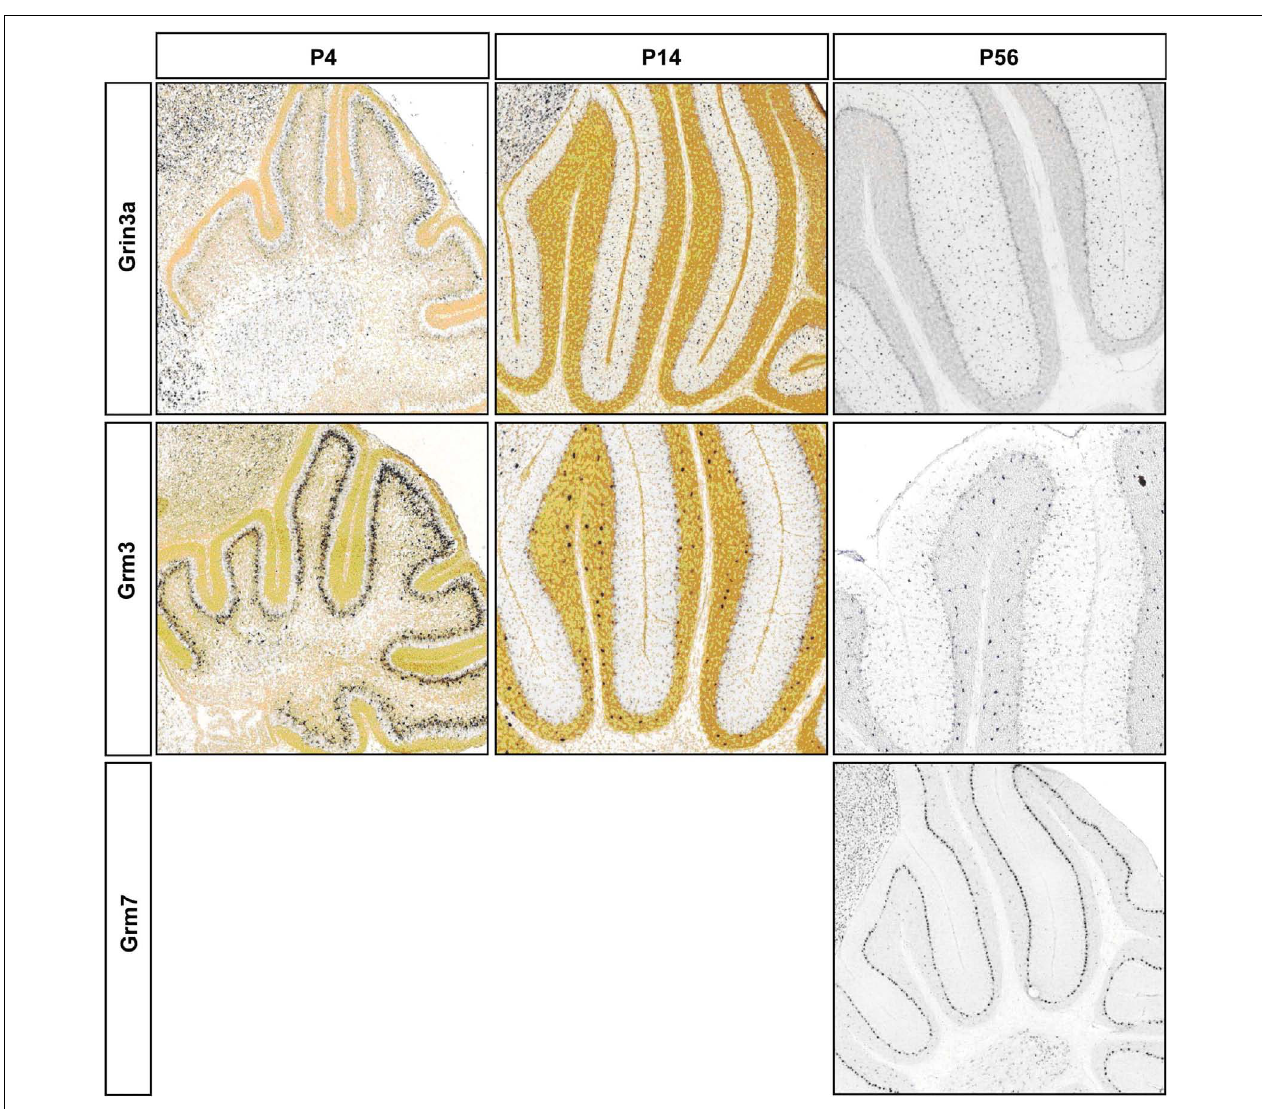
Expression changes matched with microarray developmental profiles. Grm3 signal is weaker than Golgi cells as has been reported in Ohishi et al.